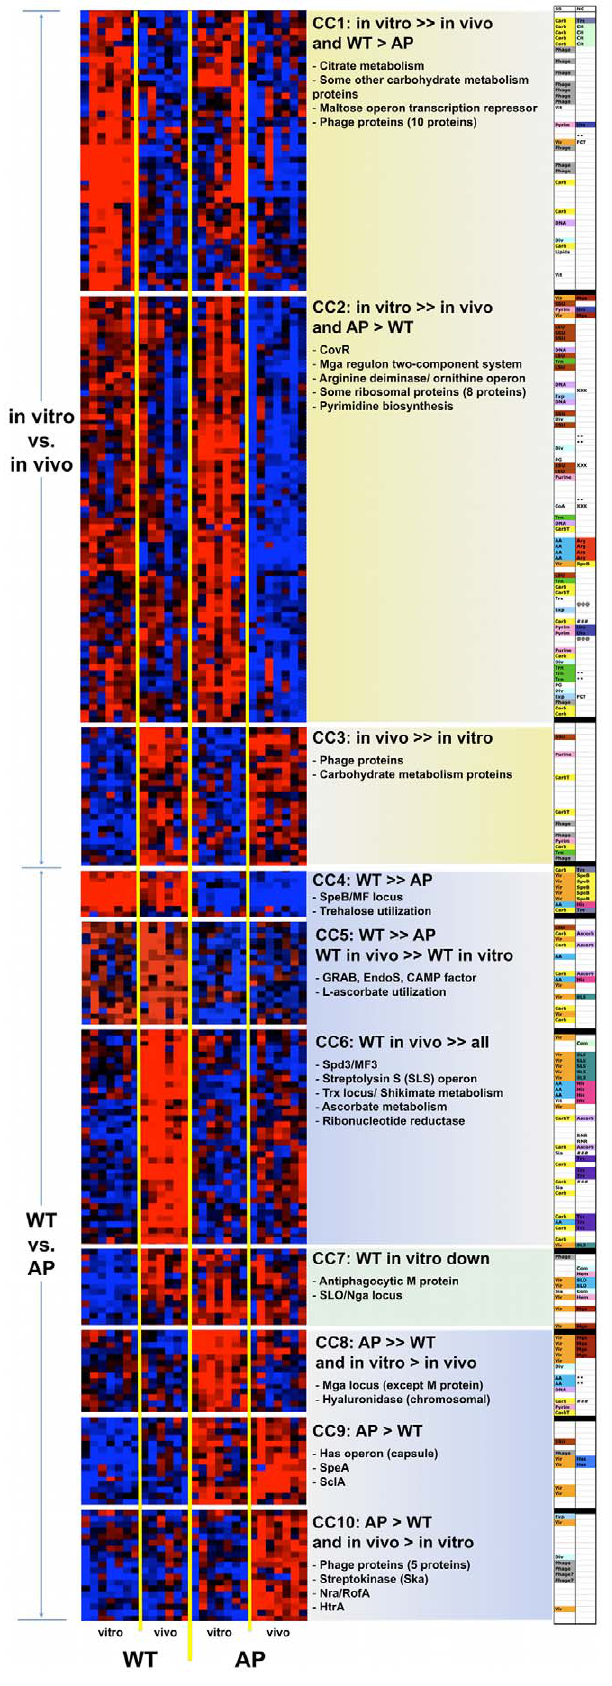
Figure 2. Pathovivogram of expression microarrays. Heat maps of clustered normalized expression values from biological replicates showing ten major coexpression clusters (CCs). Shades of red: upregulation; shades of blue: downregulation; black: expression value below threshold. CC1-CC3 are clusters that differentiate bacteria grown in vitro from those grown in vivo (vivogram) and represent the adaptational transcriptional program. CC4-CC10 are clusters that differentiate WT from AP bacteria (pathogram), all of which but CC7 represent transcriptional differences driven largely by the AP mutation. CC7 represents transcriptional differences driven both by mutation and by in vivo adaptation. The right column displays the subsystems (SS) and neighbor clusters (NC) to which these genes belong. A higher resolution version of this figure is provided online as Figure S2. Detailed annotations are provided in Table